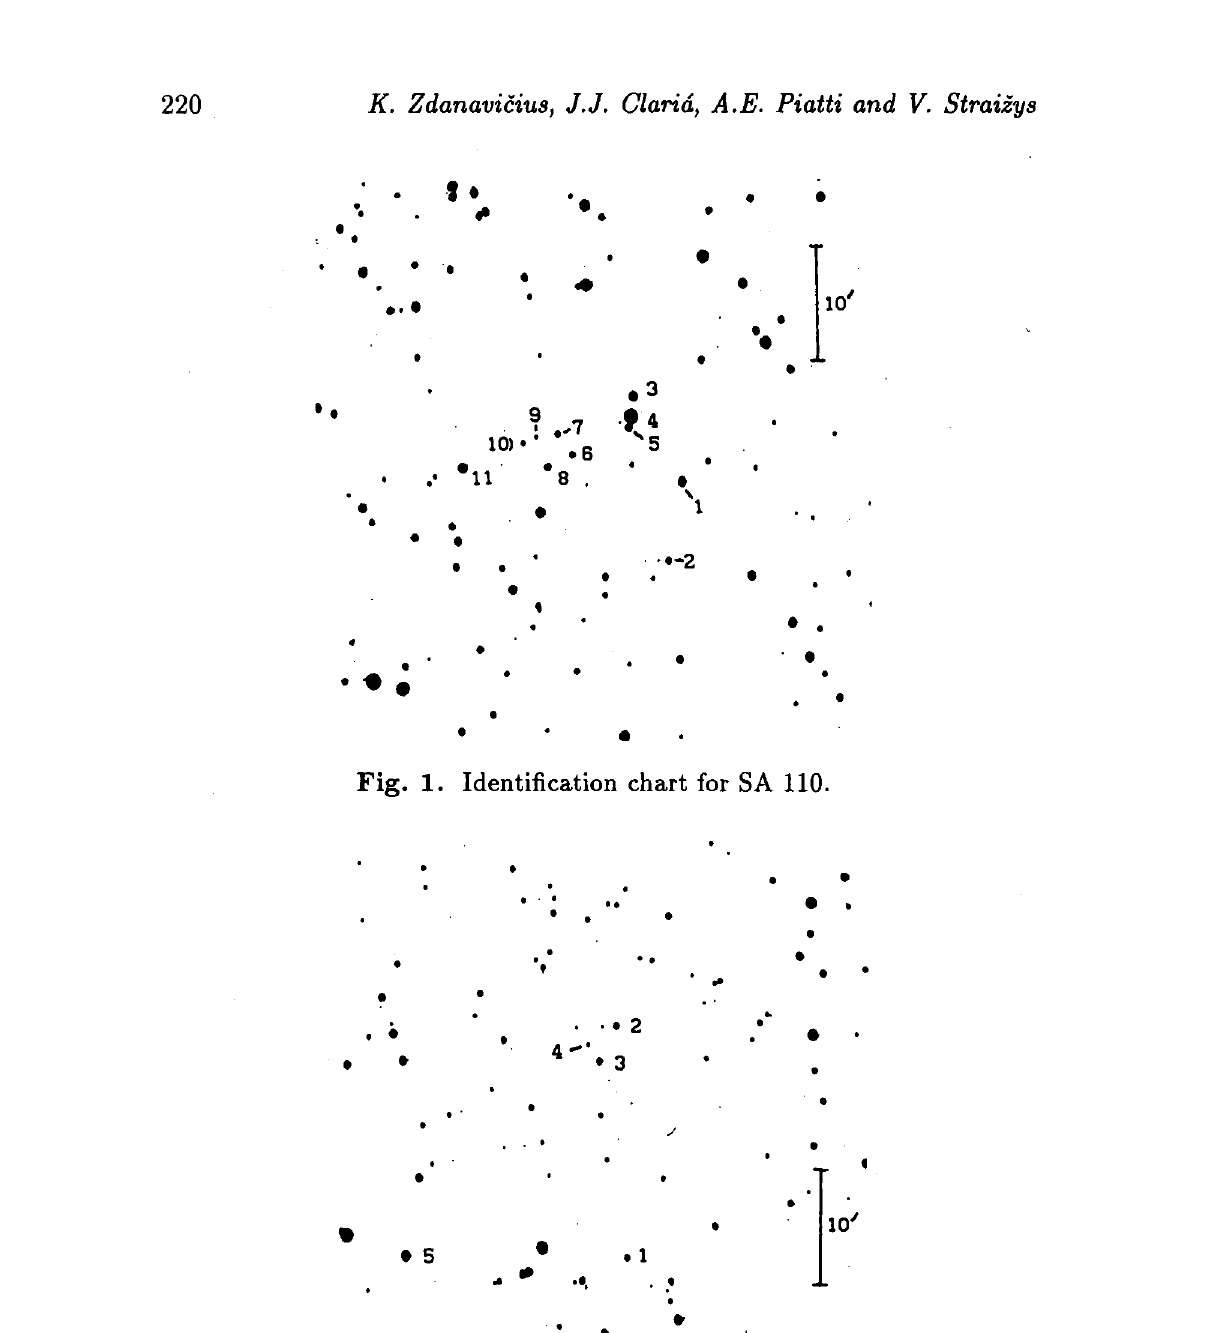
Fig. 2. Identification chart for SA